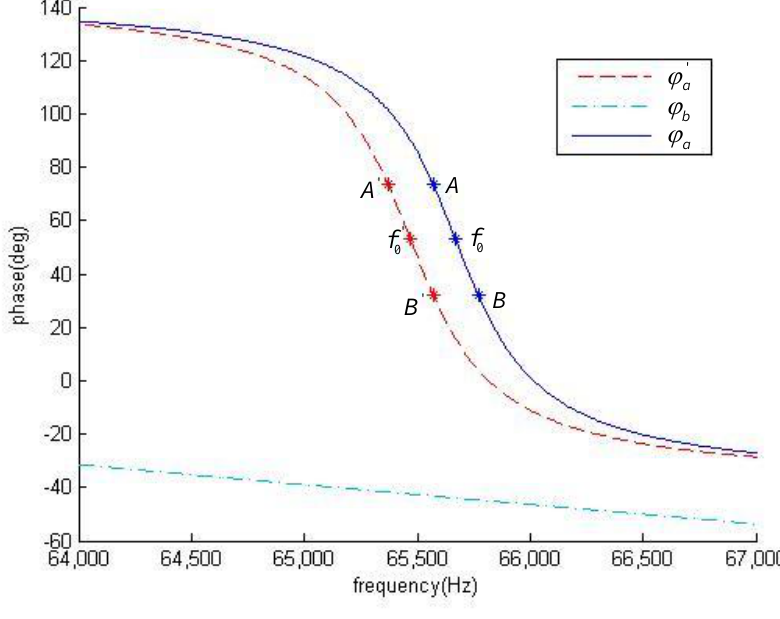
= 65,670 Hz and ∆ f = 200 0 0